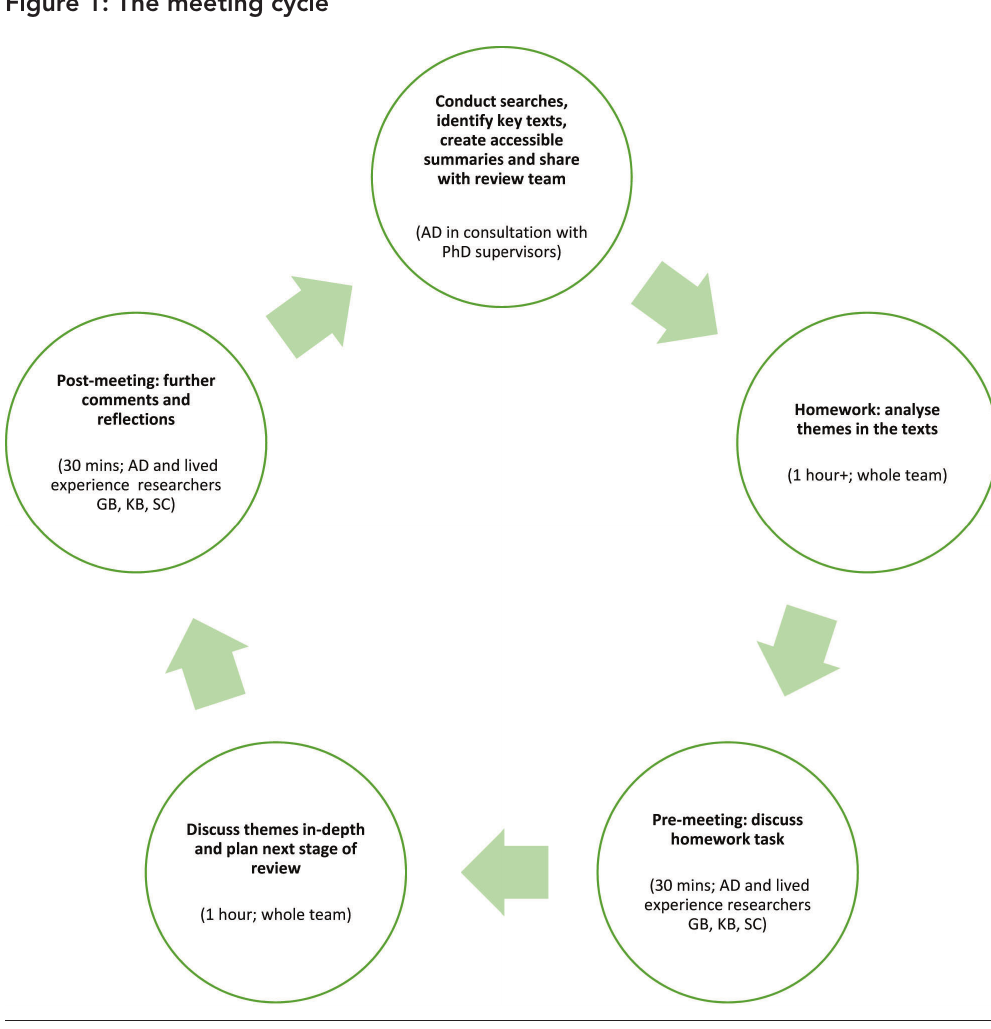
Figure 1: The meeting